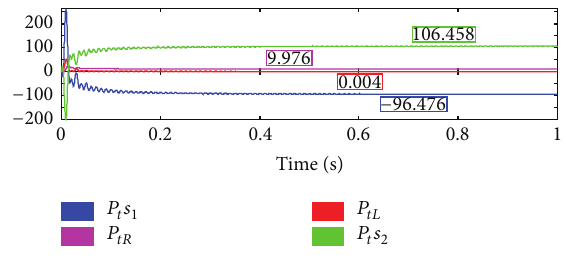
Figure 17: Sources average power responses.